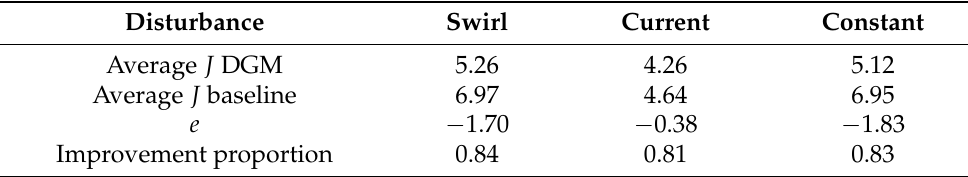
Table 1. Results for the surrogate OCP (12), comparing DGM and the baseline control. DGM provides better results, not only in terms of lower cost and average error (remember that negative error values mean that DGM is better), but also in that more than 80% of the trajectories present a lower cost with DGM.